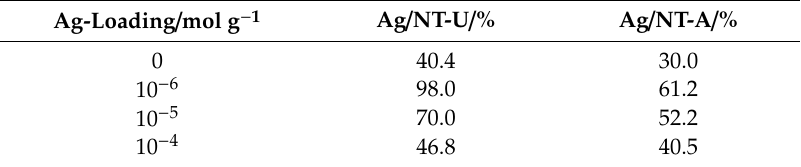
Table 3. Antibacterial e ff ects of various catalysts compared to the control sample after 90-min contact.